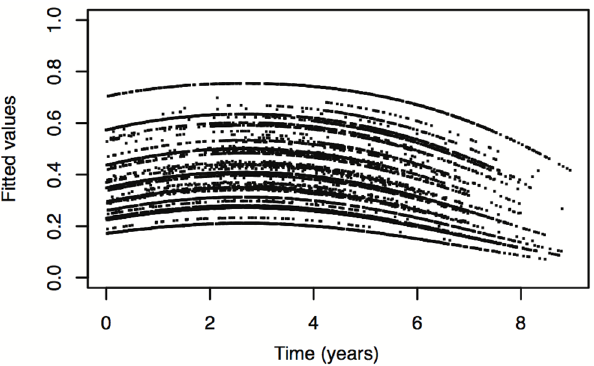
Fig 3. Estimated probability that Cost is equal to zero vs. time. Estimated probability that Cost is equal to zero vs. time, for all baseline covariate values.